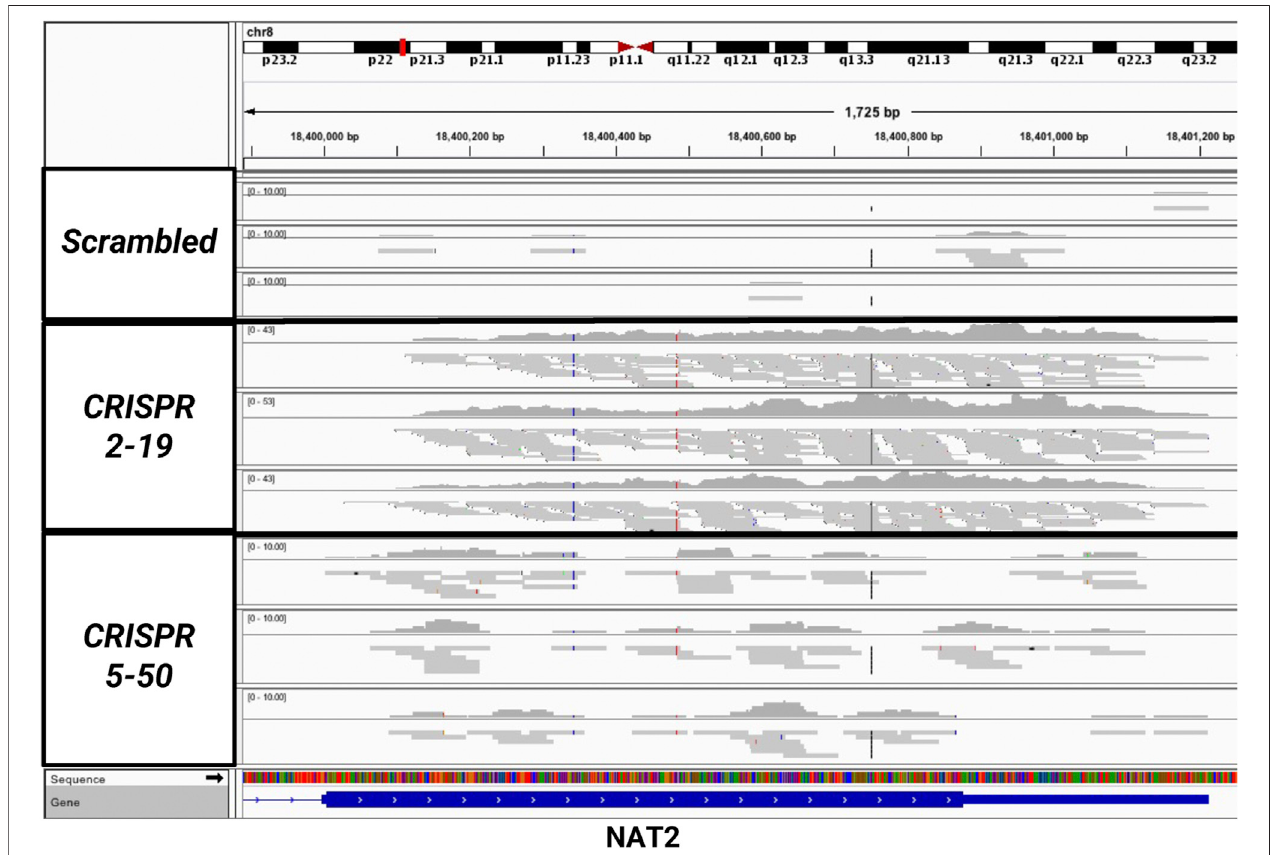
FIGURE 6 | Sequencing Reads Map to the NAT2 Gene But Only in the Two Knockout Cell Lines, CRISPR 2 – 19 and CRISPR 5 – 50 . The mapping of reads to the NAT2 gene were visualized using the Integrated Genomic Viewer in the Scrambled , CRISPR 2 – 19 , and CRISPR 5 – 50 cell lines. Each linear gray bar represents an individualread.Theredandbluelinesrepresentpositionsinthereadwhereasinglenucleotidepolymorphismcomparedtothereferencegenomeispresent.Zerotovery fewreadsmappedtoNAT2inthe Scrambled celllinesamples,manyreadsmappedtoNAT2inthe CRISPR2 – 19 celllinesamples,andamedium amountofreads mapped to NAT2 in the CRISPR 5 – 50 cell line samples.